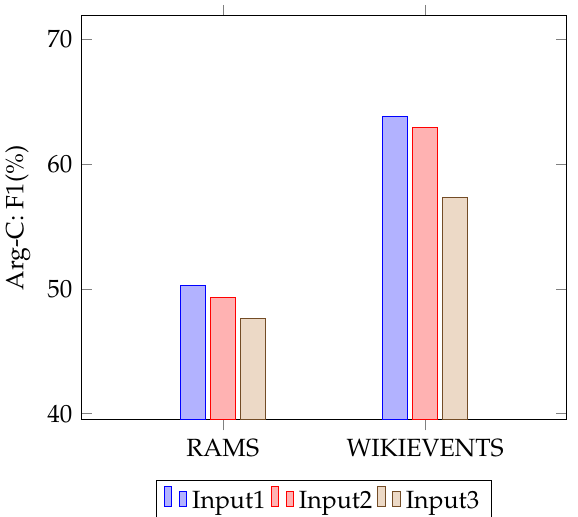
Figure 4. The impact of input encoder content, where Input1 indicates our method (RKDE), where we input the document into the encoder and the prompt into the decoder. Input2 indicates that the document and prompt were spliced into the encoder. Input3 indicates that the document was input into the encoder while not using the